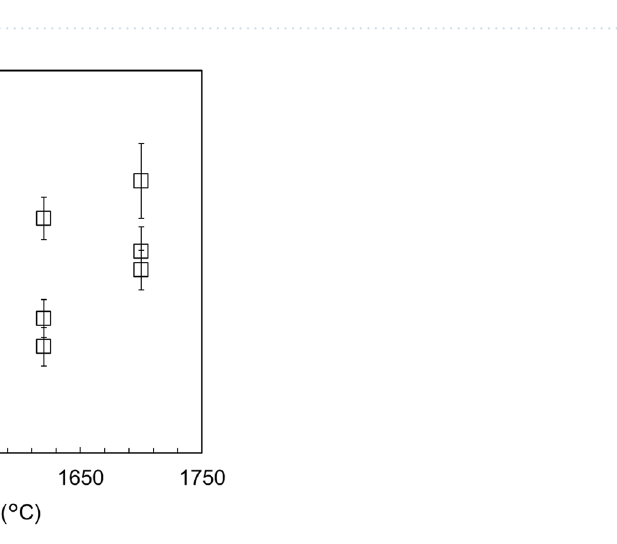
Figure 1. BSE images of recovered sample from 28 GPa, 1400 °C (OT2259). The left figure is a whole BSE image of the recovered sample. The right figures are the BSE images of two samples obtained by FE-SEM after high-resolution SIMS analysis; ( a ) Al-free system and ( b ) Al-bearing system. Circles correspond to analysis points. Brg bridgmanite.